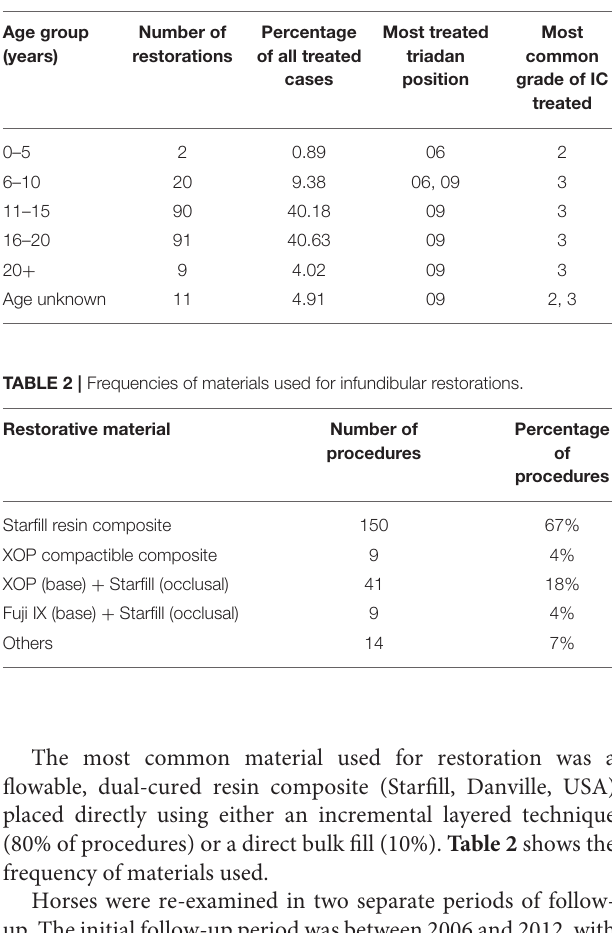
null hypothesis that the variables were independent of each other could be rejected, demonstrating that the variables were related.